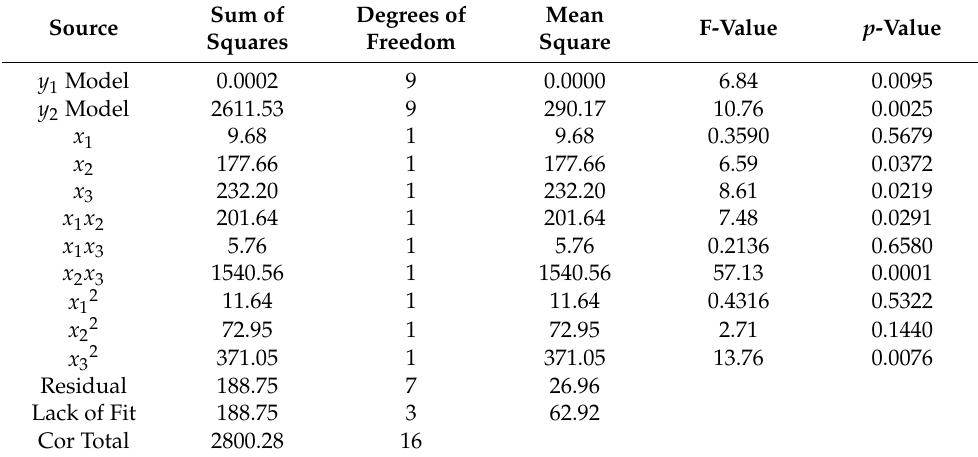
Table 3. ANOVA Results of Regression Equations.